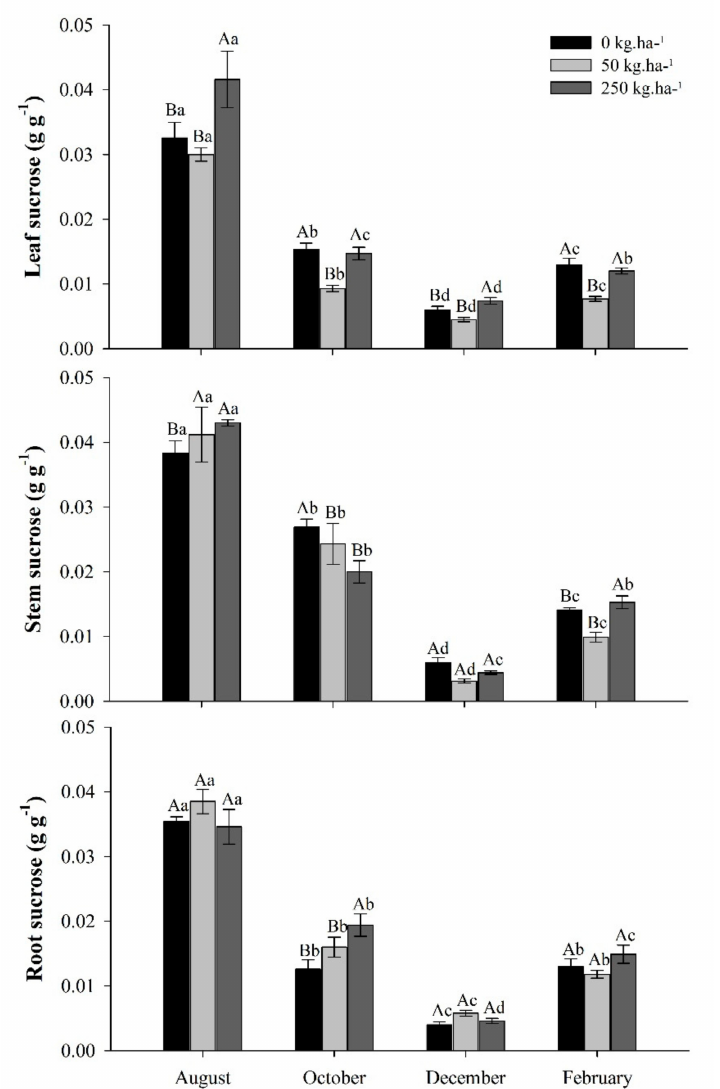
Figure 5. Sucrose from leaves, stems, and roots of C. guianensis plants fertilized with phosphorus at different collection periods. Means followed by distinct letters differ from each other ( p < 0.05), where uppercase letters represent the differences between treatments and lowercase letters between the evaluation